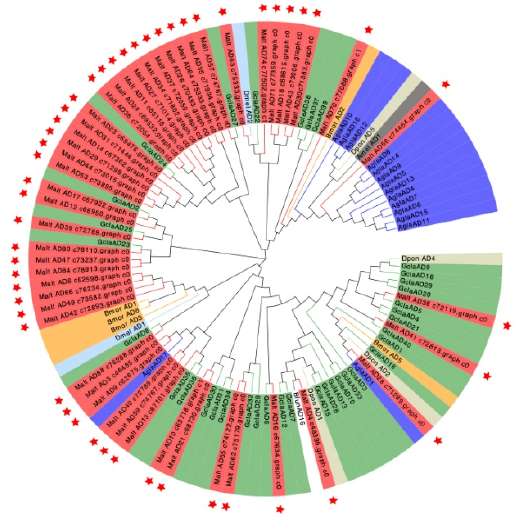
Figure 2. Phylogenetic analysis of alcohol dehydrogenase genes. Included are alcohol dehydrogenase (AD) genes from Monochamus alternatus (Malt), Grosmannia clavigera (Gcla), Anoplophora glabripennis (Agla), Bombyx mori (Bmor), Apis mellifera (Amel), Dendroctonus ponderosae (Dpon), and Drosophila melanogaster (Dmel). AD genes from different species are indicated by different colors. AD genes of M. alternatus are marked with red stars.